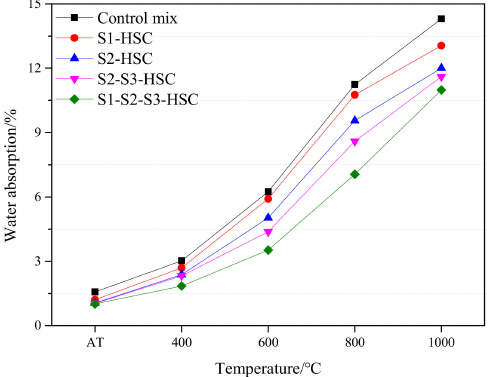
Figure 9. Water absorption of the specimens subjected to elevated temperatures.